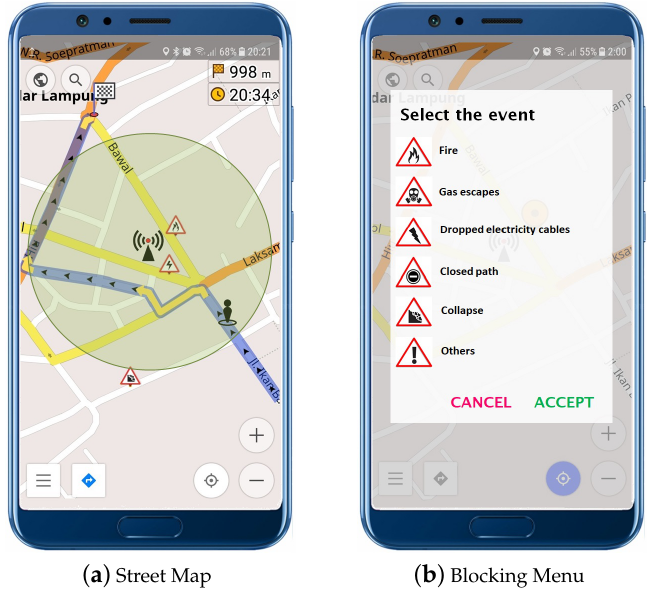
Figure 8. Screenshots of the ESS